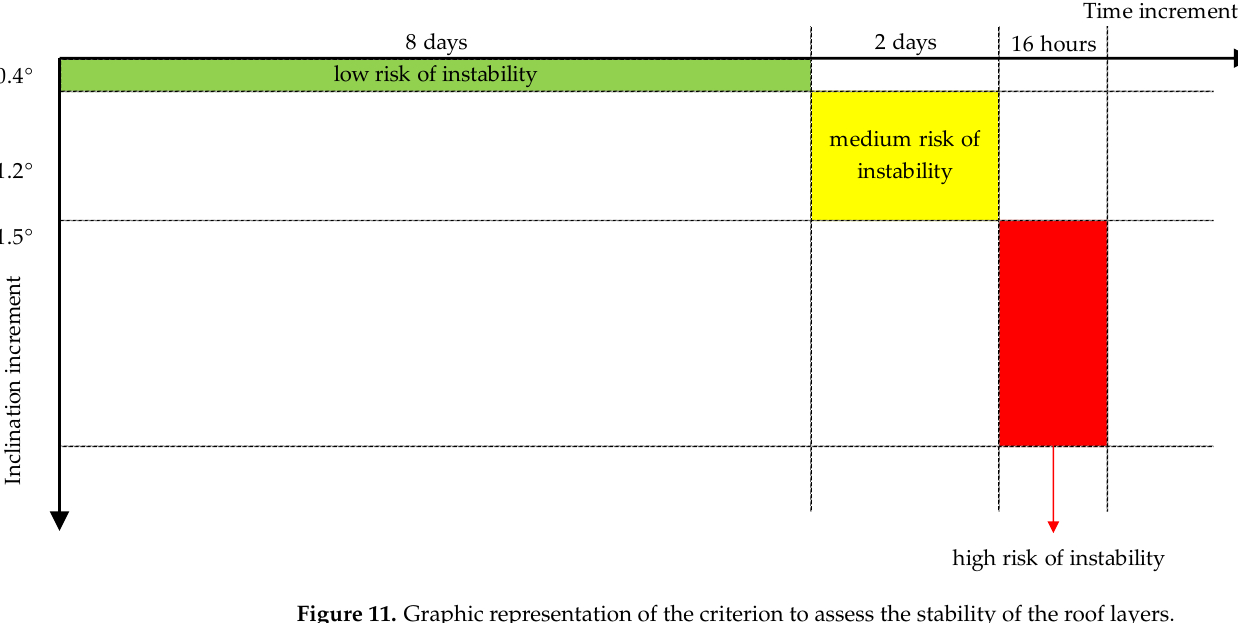
Figure 11. Graphic representation of the criterion to assess the stability of the roof layers.